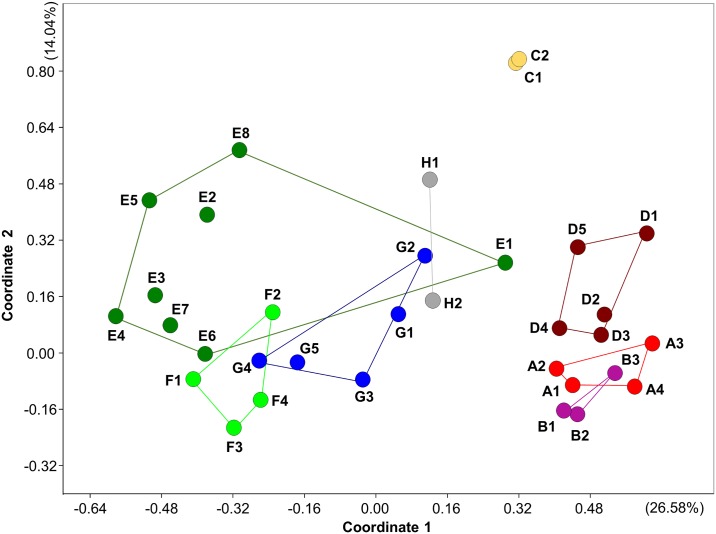
PCoA plot of pairwise population genetic distances (using Cavalli-Sforza and Edwards estimator after FREENA-INA null allele correction).Percentage variances represented by axes are shown in parentheses. Codes and colours of sites correspond to those of Table 1 and Fig 1.